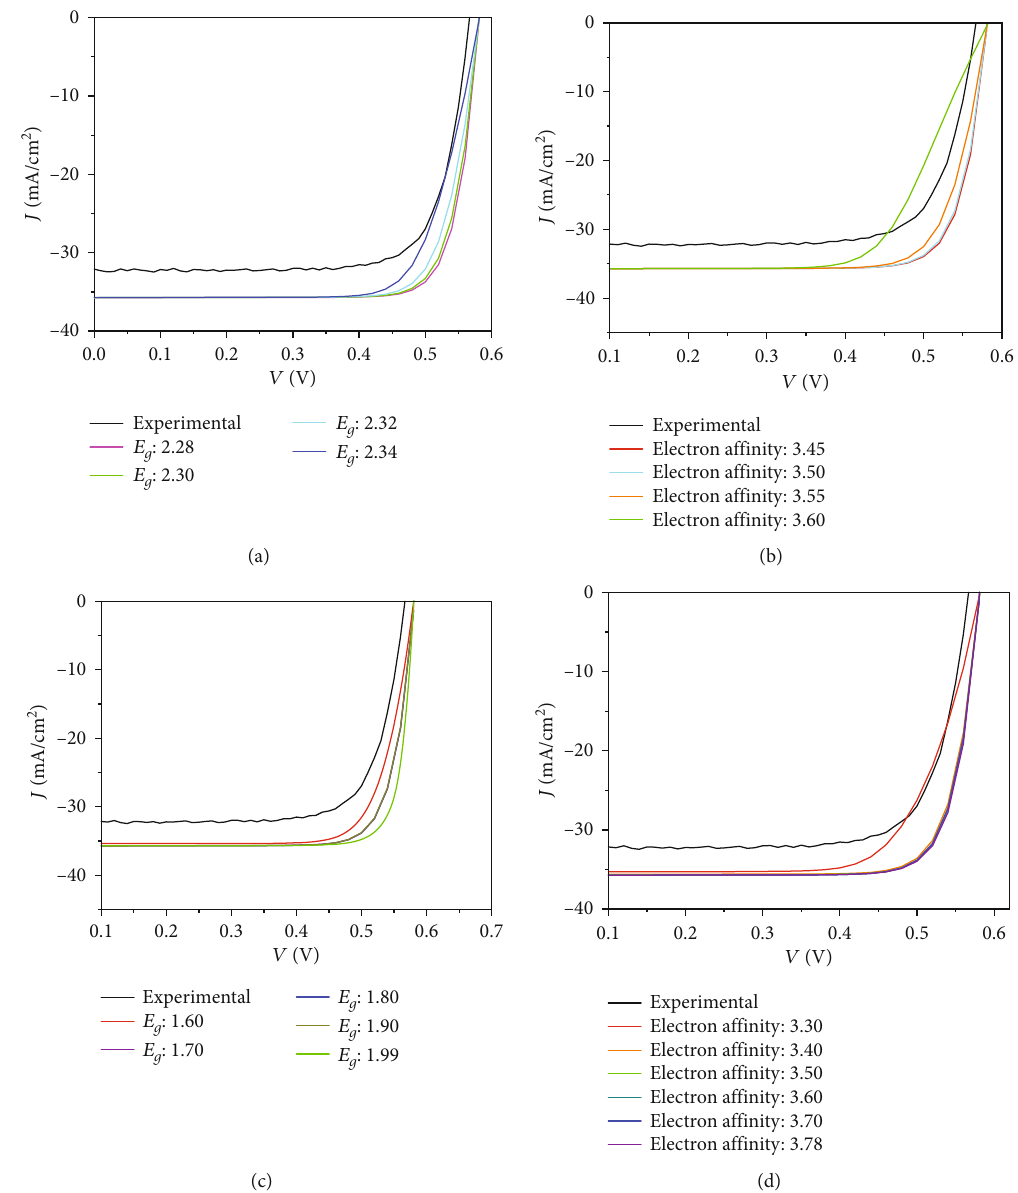
Figure 3: Comparison between the J – V curves of the simulated MSHJ solar cells with (a) di ff erent optical E optical E of SiO (Mo)2, (c) di ff erent a ffi nities of SiO g x